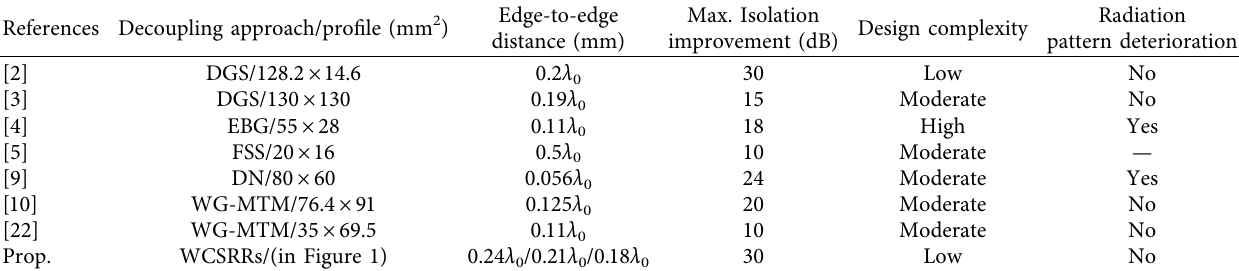
Table 2: Comparison of the proposed antenna array with previous decoupling